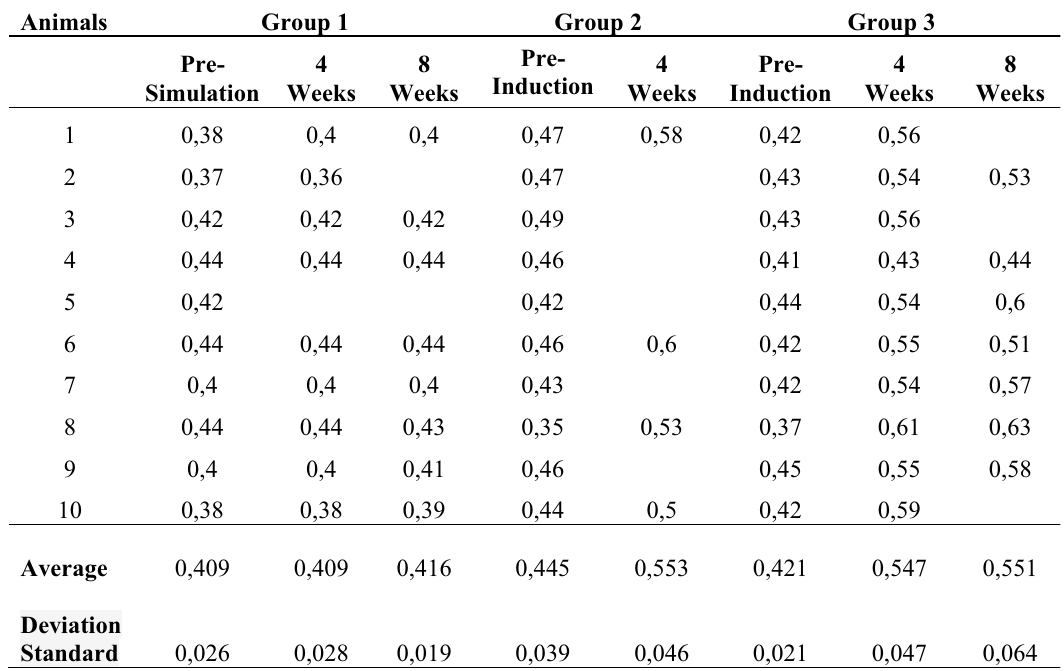
TABLE 1 - Ventricular ratios obtained by MRI in the animals